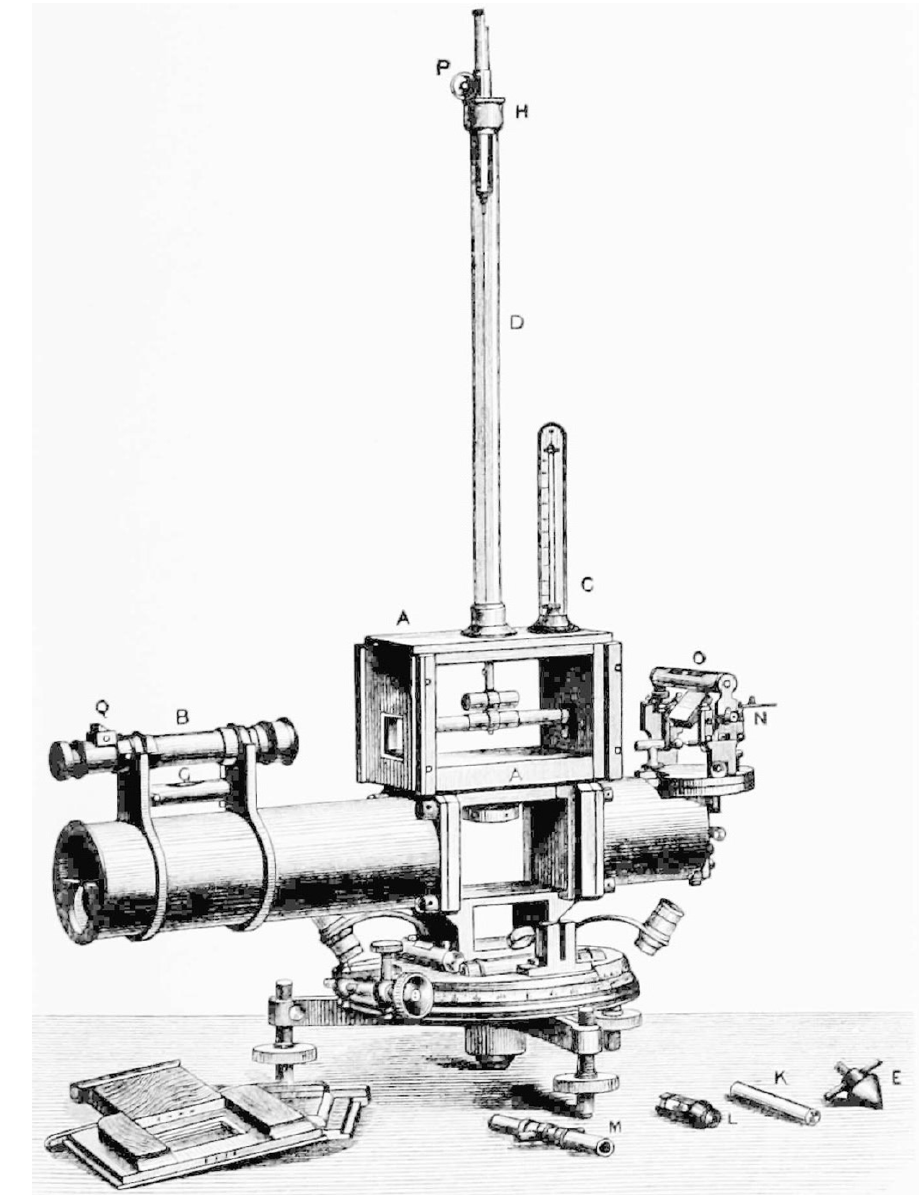
Figure 11. This instrument dealt with vibrations for intensity measurements, which were calibrated at Kew Observatory (Multhauf and Good, 1987). In fact, the vibrations were initiated in such a fashion as to avoid vertical vibrations. During the process, torsion-free suspension fibers were